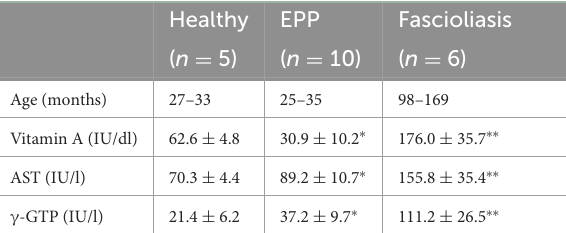
TABLE 1 Serum vitamin A (retinol), AST, γ -GTP in healthy, eosinophilic proliferative phlebitis (EPP), and fascioliasis cattle. Healthy EPP